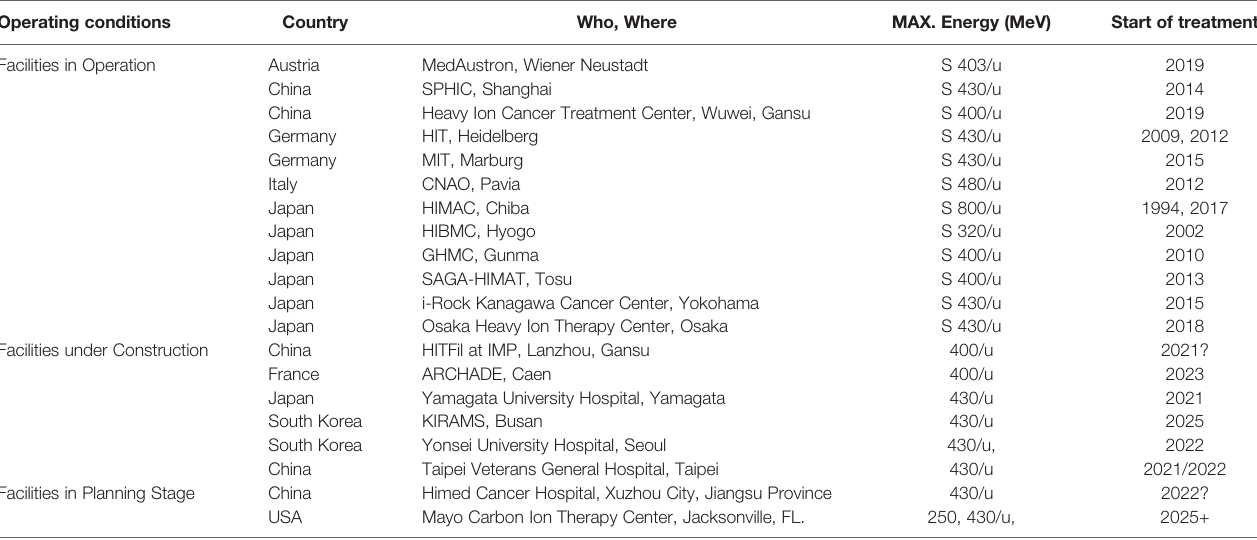
TABLE 1 | Distribution of the world C-ions therapy center in operation, under construction and in planning stage. Operating conditions Country Who, Where